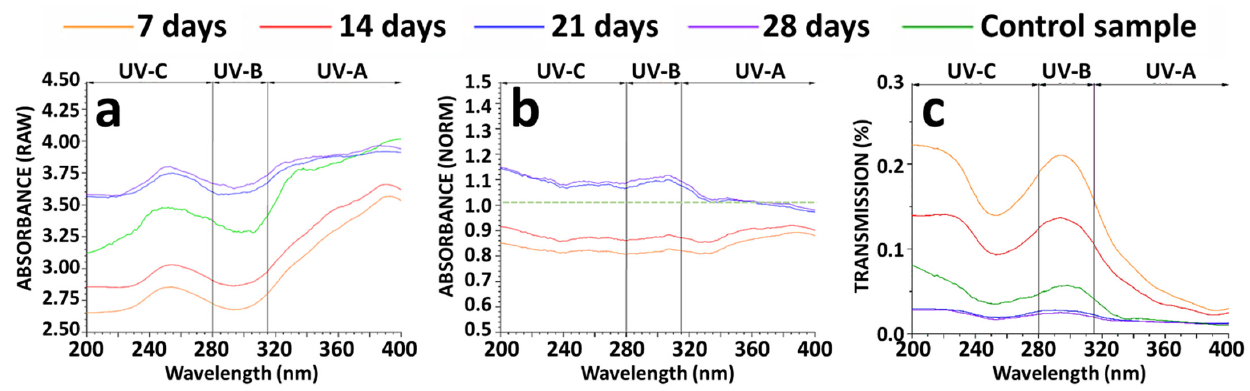
Figure 3. Absorbance and transmittance optical properties of the human skin substitutes and native human skin control (CTR). ( a , b ) The absorbance, the normalized absorbance and the transmission were studied during 7, 14, 21 and 28 days of in vitro development in culture. ( c ) Native human skin was used as the control sample and for the absorbance normalization. The transmission was calculated as a function of wavelength.